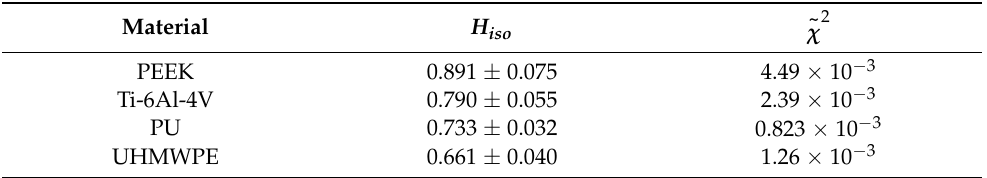
Table 1. H iso values obtained from linear fittings of the curves of Figure 3 and the corresponding reduced chi-square ( (cid:101) χ 2 ) .